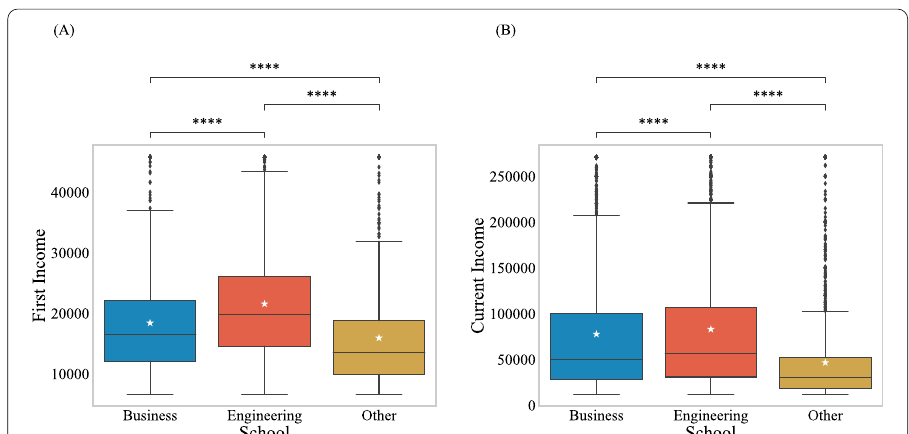
Fig. 6 First Income and Current Income boxplot based on School distribution count